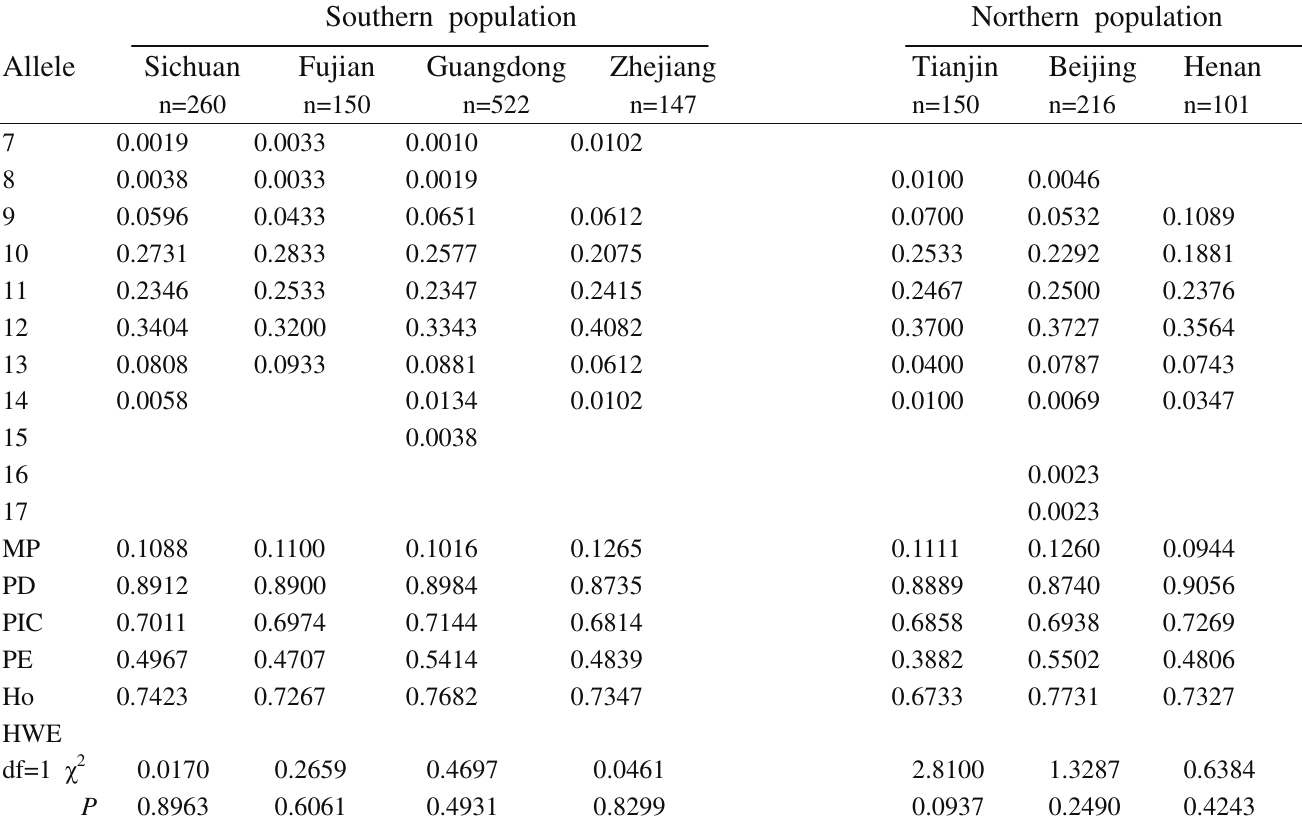
Table S5- Genetic polymorphism at the CSF1PO locus for the seven Chinese population groups. Southern